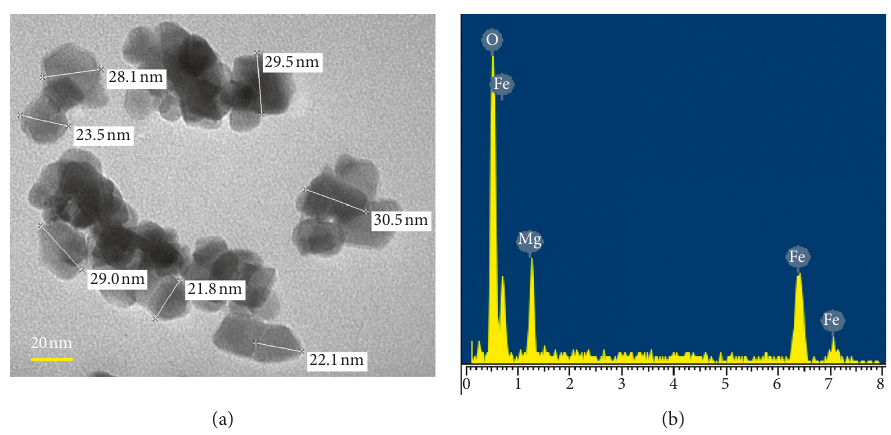
Figure 4: TEM and EDS of MgFe